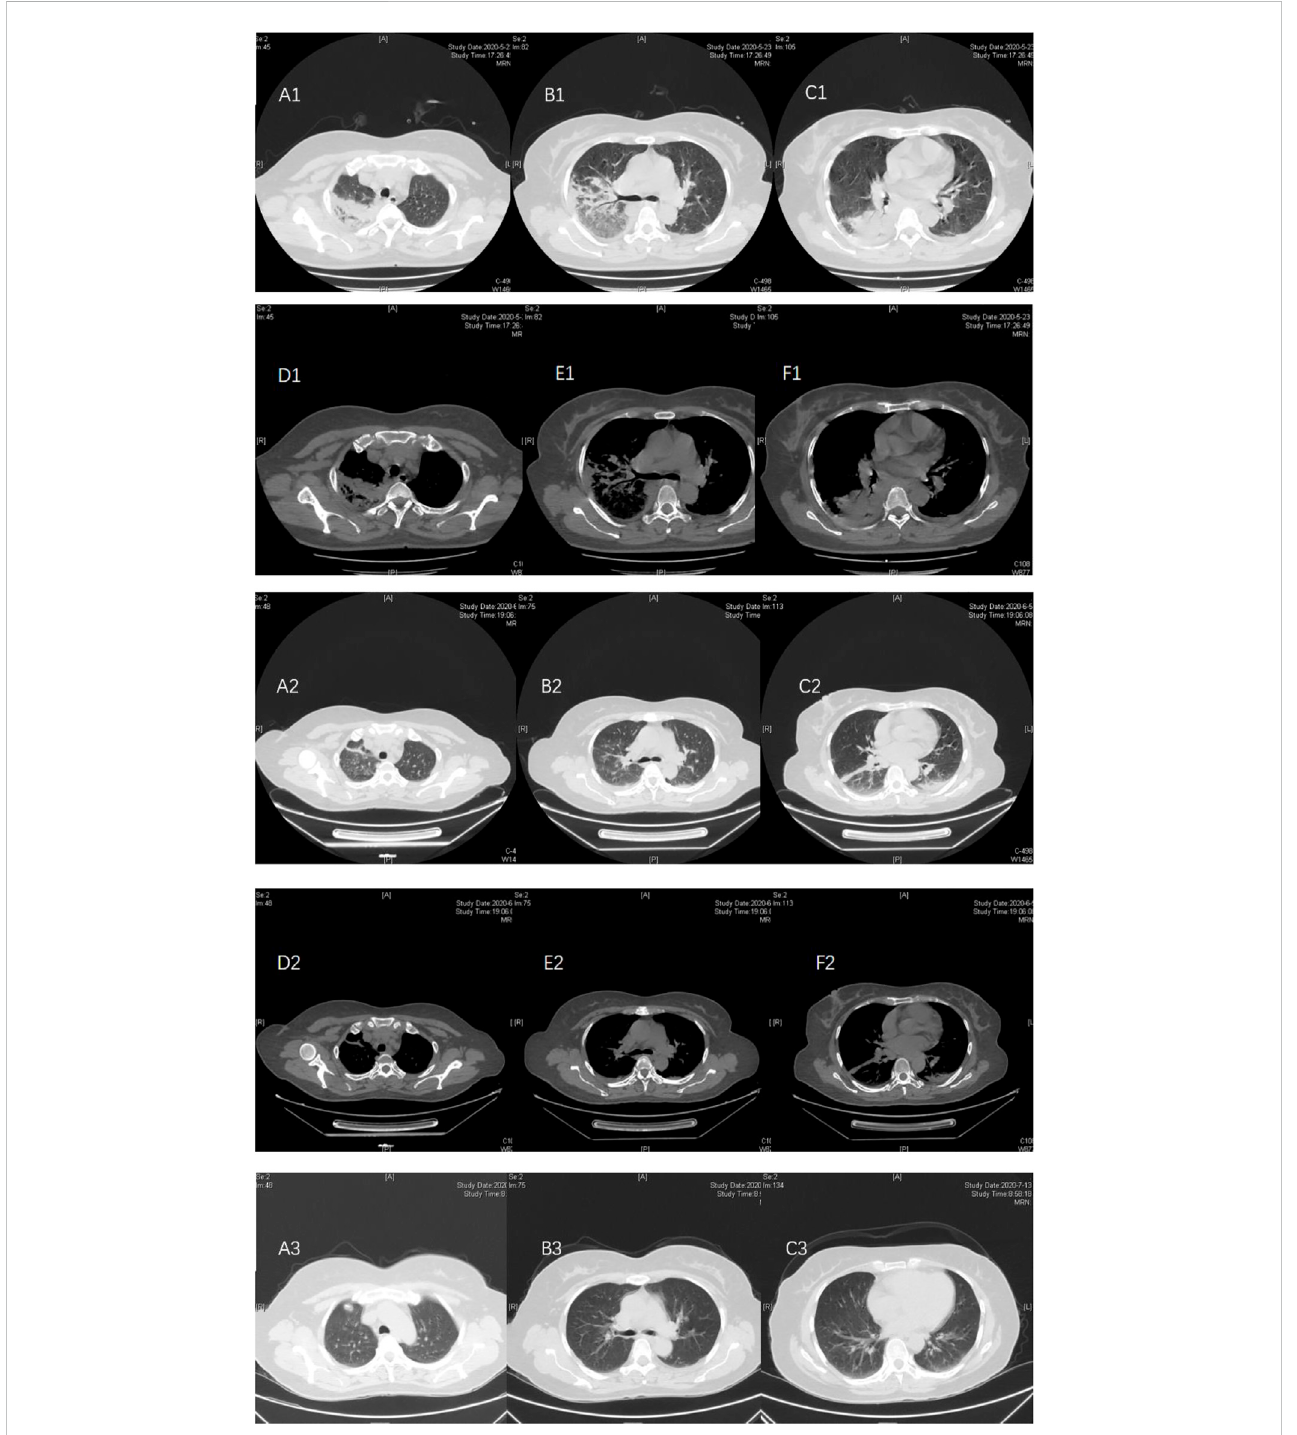
FIGURE. 1 Case 1, a 51-year-old female, was admitted on 21 May, 2020, due to “ headache and fever for 10 days. ” At admission, pulmonary CT (May 21) showed multiple patchy consolidation and exudation in the right upper and lower lungs. A small amount of pleural effusion (A1 – F1) on both sides. After piperacillin sulbactam + doxycycline treatment, the pulmonary CT reexamination on 5 June. 2020, showed that the absorption of some lesions in the right upper lobe and the right lower lobe was reduced, and new clockwork-like high-density shadows were seen near the pleura in the left lower lobe. Bilateral pleural effusion was absorbed earlier (A2 – F2) . After discharge, doxycycline treatment was continued; on 13 July, 2020, the reexamination of low-dose CT in the lungs showed that multiple lung lesions and bilateral pleural effusion were completely absorbed (A3 – C3)